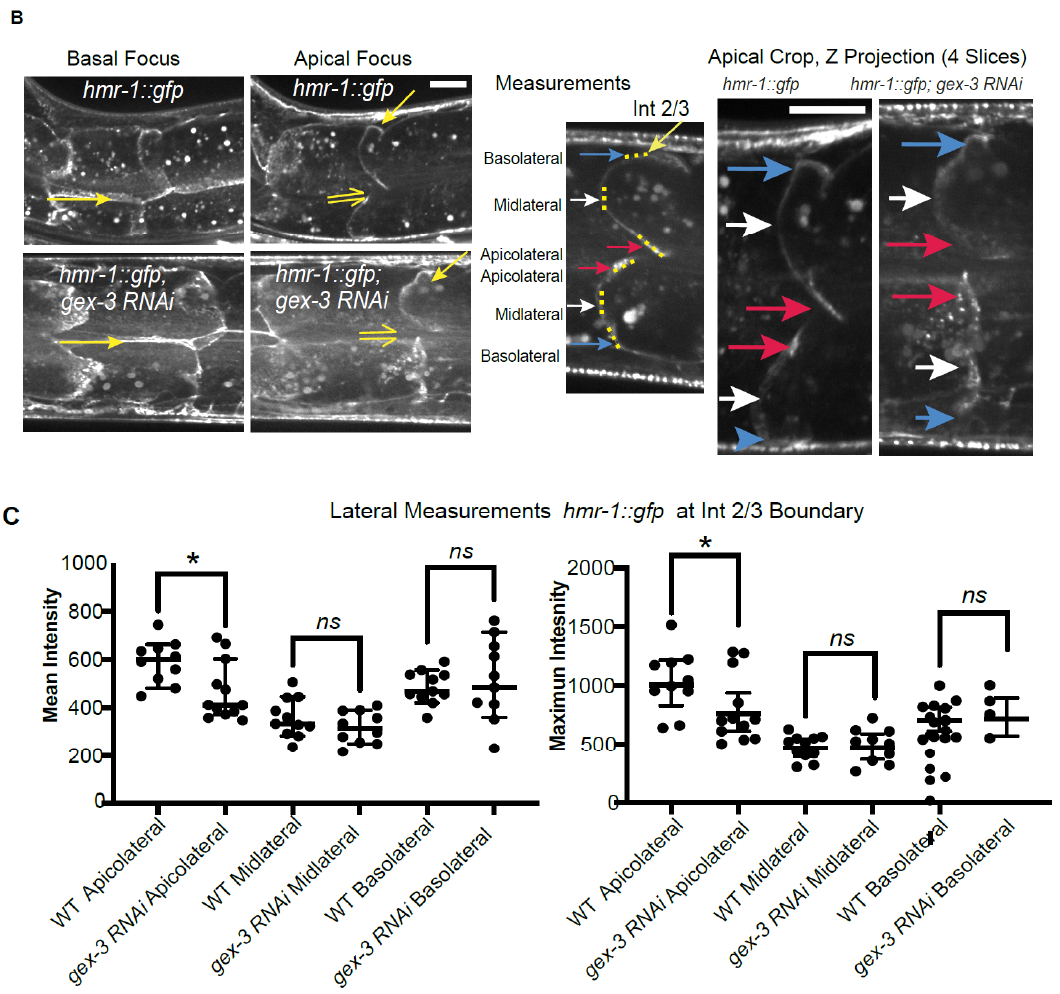
Figure 1. Cadherin localization is polarized and this depends on WAVE. ( A ) Upper panel: Cartoon of a C. elegans worm, oriented anterior to posterior, with an emphasis on the intestine, which begins right behind the pharynx (bilobed structure at the anterior) and extends for the length of the worm. The region within the dotted line is where most of the imaging and measurements in this study were conducted, especially at the boundary between intestinal rings 2 and 3 (Int 2/3). Ring 1 has four cells, while rings 2–8 have two cells each. Lower panel : Cartoons to illustrate how a typical region of the intestine, with two cells, is oriented. Since worms are usually imaged on their side, rings 2 and 3 have a basal regions at the top surface (Basal Focus), while focusing at the center of the intestine reveals the apical region, including the lumen, and the lateral regions where two rings meet. ( B ) Cadherin/HMR-1 endogenously tagged with GFP using CRISPR [23] is expressed post-embryonically in various epithelia. Parallel yellow arrows indicate the apical lumen, which shows low enrichment of HMR-1::GFP. Yellow solid arrow indicates the lateral junction between rings 2 and 3. Center panel: The levels of HMR-1::GFP were measured at apicolateral, midlateral and basolateral regions. The branched actin regulator GEX-3 was depleted with two day RNAi feeding treatment, and the same regions were compared. Right 2 panels: Crop of representative ring 2/3 lateral regions, including a Z-projection from 4 slices, 0.4 μm apart, to better illustrate the differences between controls and animals depleted of gex-3. All images were obtained on a Zeiss AxioImager Z1 with a Yokogawa CSUX1-5000 spinning disc with a Plan Apo 63X/1.4NA Oil lens. All worms shown in this and other figures are oriented with anterior to the left. Scale bars shown in this and all figures are 5 μm long unless otherwise stated. ( C ) Mean and maximum intensities of HMR-1::GFP at each region of the lateral membrane. For this and all figures, the Line Scan tool of ImageJ was used to compare fluorescent intensities. For these measurements, a line of 35 pixels (3 μm) was drawn in the lateral region indicated and both mean and maximum intensities were recorded. Each animal was measured at the Int2/3 lateral membrane, some on one side, and some on both sides if both were in focus. Seven animals were used for the controls, and eight for gex-3 RNAi. Statistical analysis was performed with Graphpad Prism. For this and other figures, error bars show standard error of the mean (SEM). Asterisks mark statistical significance, * = p < 0.05, ns = not